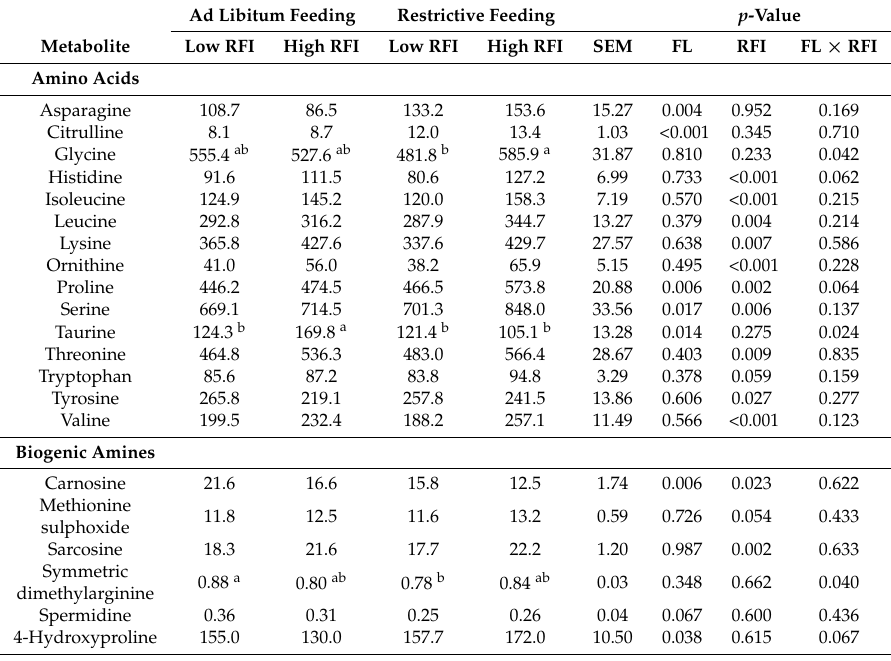
Table 1. Selected serum amino acids and biogenic amines ( µ mol/L) in low and high residual feed intake (RFI) broiler chickens fed either ad libitum or restrictively.